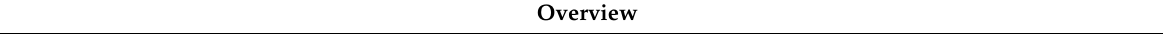
Table 1. Components of the BCLT